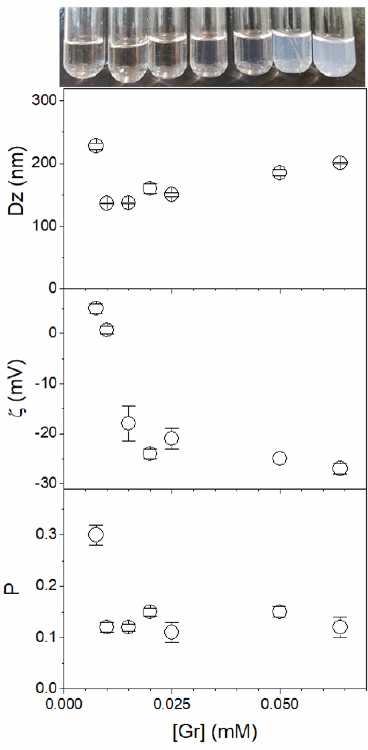
Figure 2. Effect of gramicidin (Gr) concentration on the physical properties of Gr dispersions in water and 1% trifluoroethanol. Measurements were performed 30 min after preparation of the Gr dispersions. Physical properties were the macroscopic aspect, the mean z-average diameter (Dz), the zeta potential (ζ), and the polydispersity (P). All measurements represent a mean value ± the mean standard deviation.